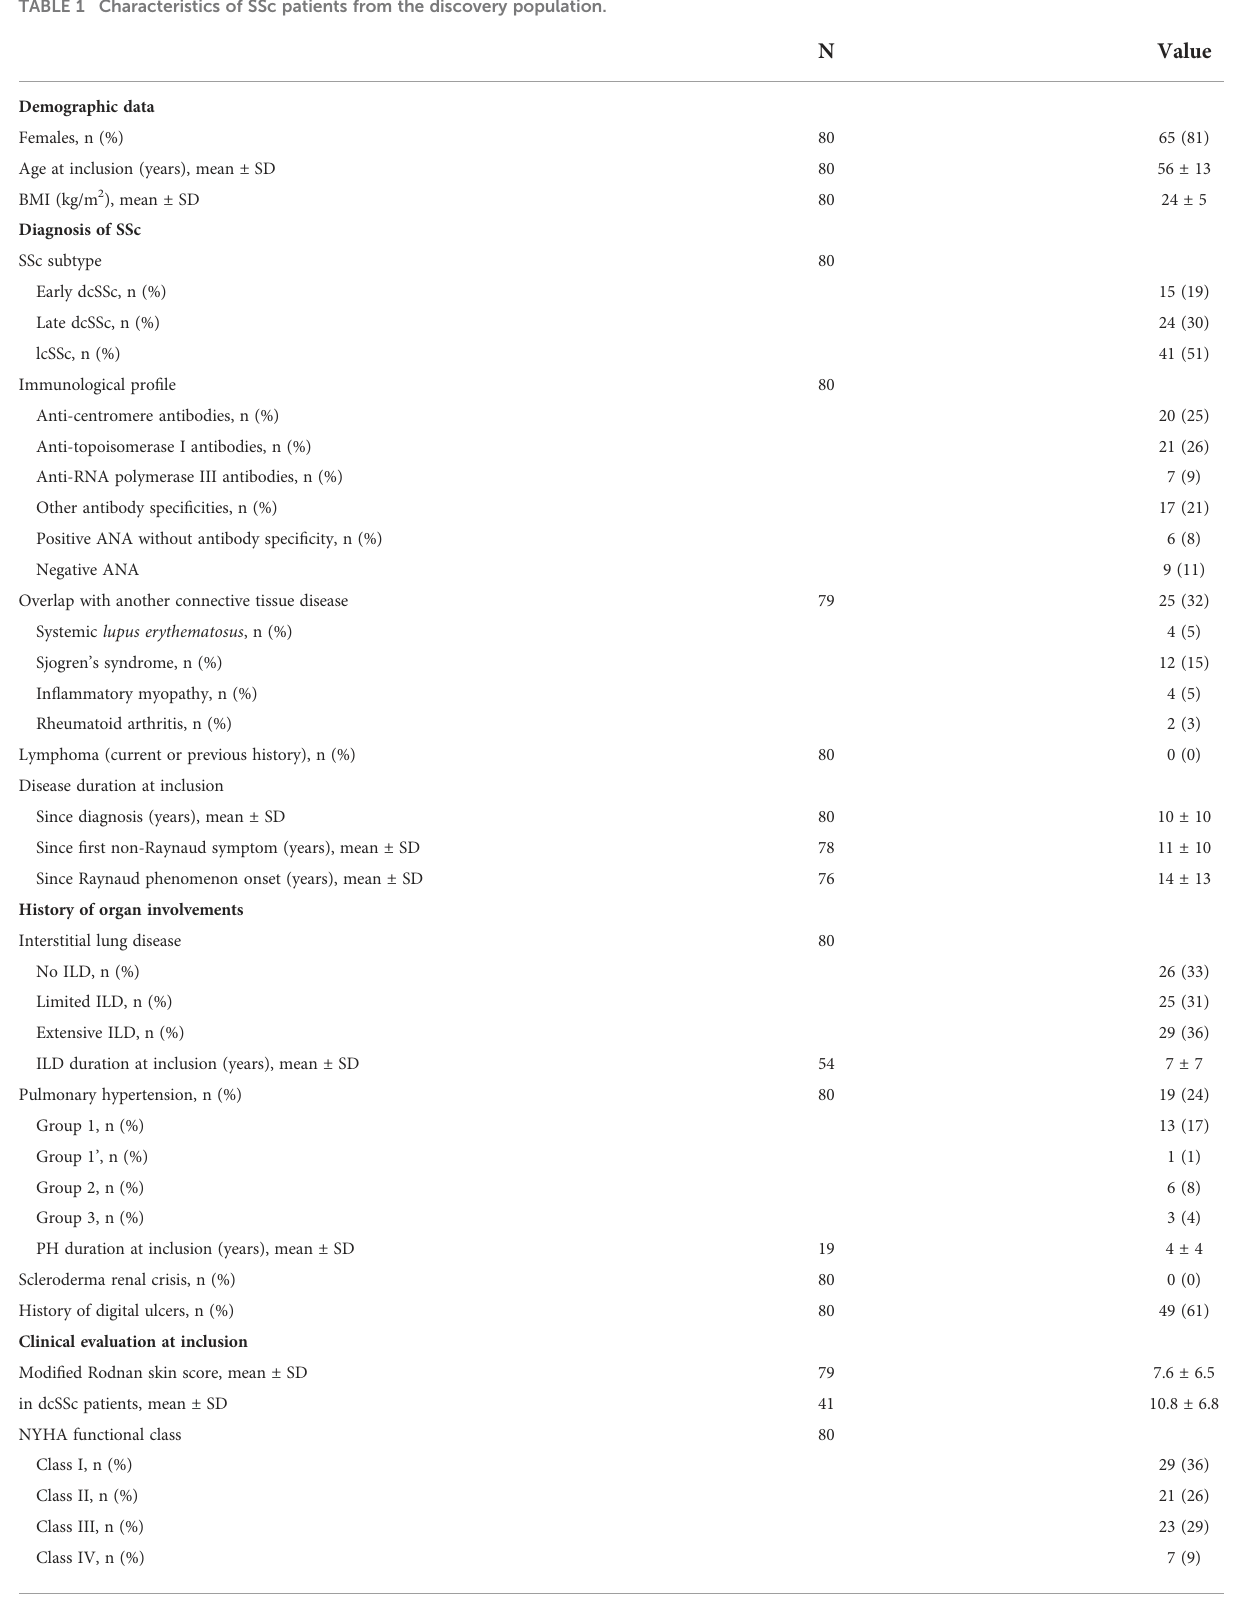
TABLE 1 Characteristics of SSc patients from the discovery